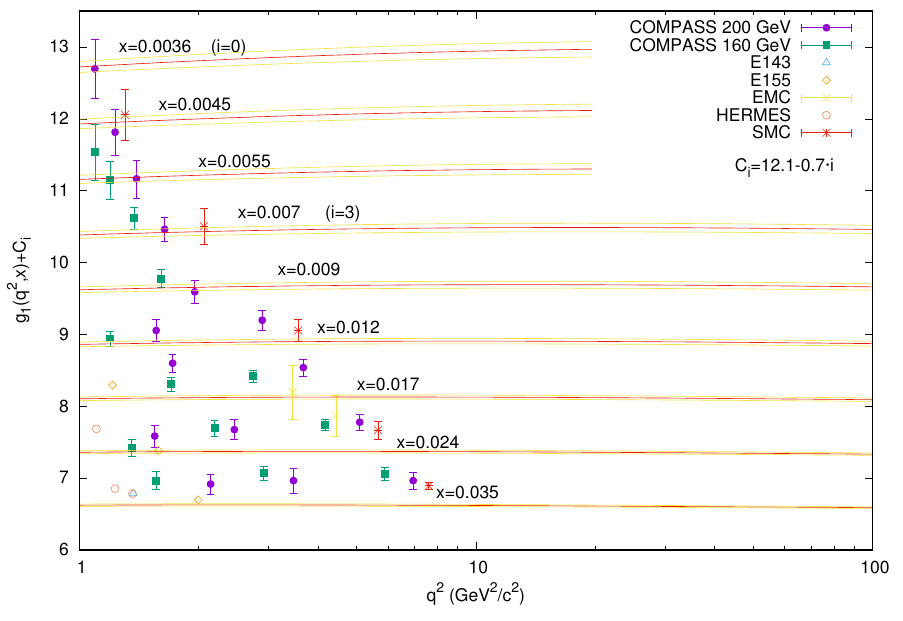
Figure 6. Red curves display our (cid:12)t for the g 1 structure function as a function of q 2 for di(cid:11)erent values of the Bjorken variable, compared to the experimental data presented in [16] and references therein, while the yellow lines are the values of g 1 considering the error on C . The best (cid:12)t corresponds to x < 0 : 01 (larger values of the Bjorken parameter are shown for completeness) obtaining a constant C = 0 : 0195 (cid:6) 0 : 0024 with a (cid:31) 2 = 0 : 27. Note that following reference [16] for each value of x d : o : f :